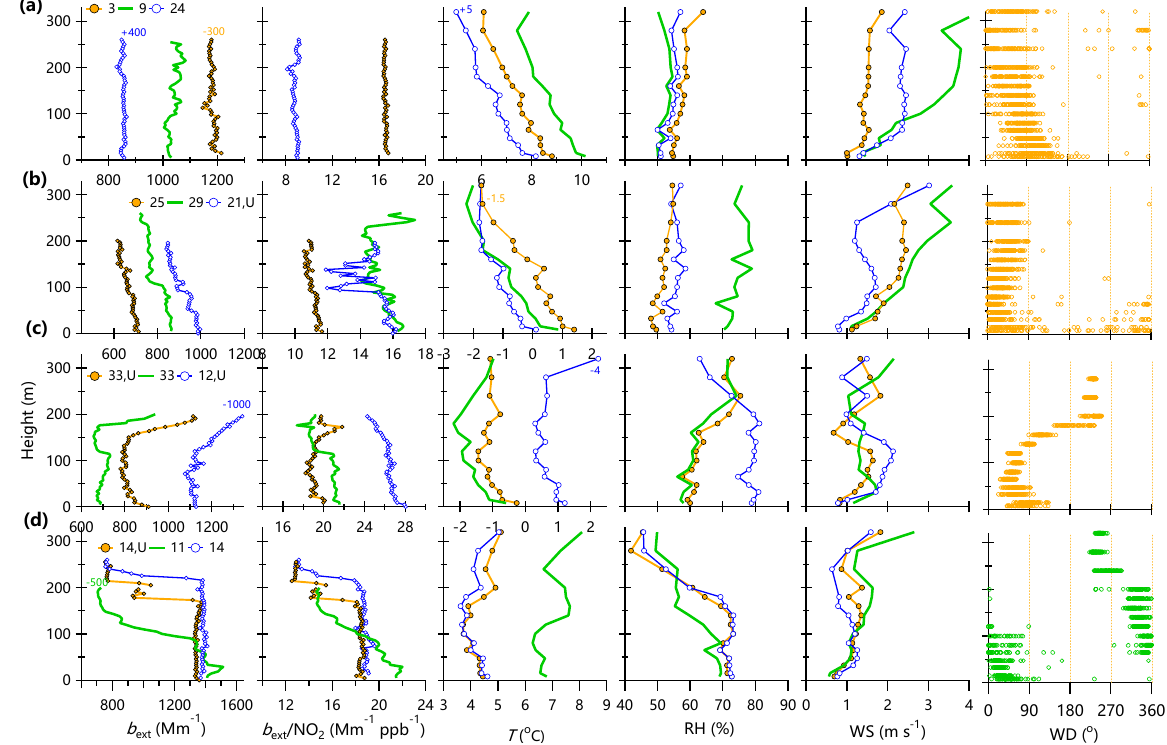
Figure 4. Four selected types of vertical profiles of b ext , b ext / NO 2 , T , RH, and WS. “U” in the legend indicates the “up” experiments, the others are the “down” ones. The vertical profile 9 (V9) for b ext / NO 2 is missing because NO 2 data were not available. The rightmost panels show four selected vertical profiles of WD, i.e., V3, V25, V33, and V11. For clarity, some vertical profiles were offset by certain values as indicated by “ + ” or “–” in the figure. Note that all vertical profiles reaching 260m were measured at daytime, while those of 200m were measured at nighttime (Table